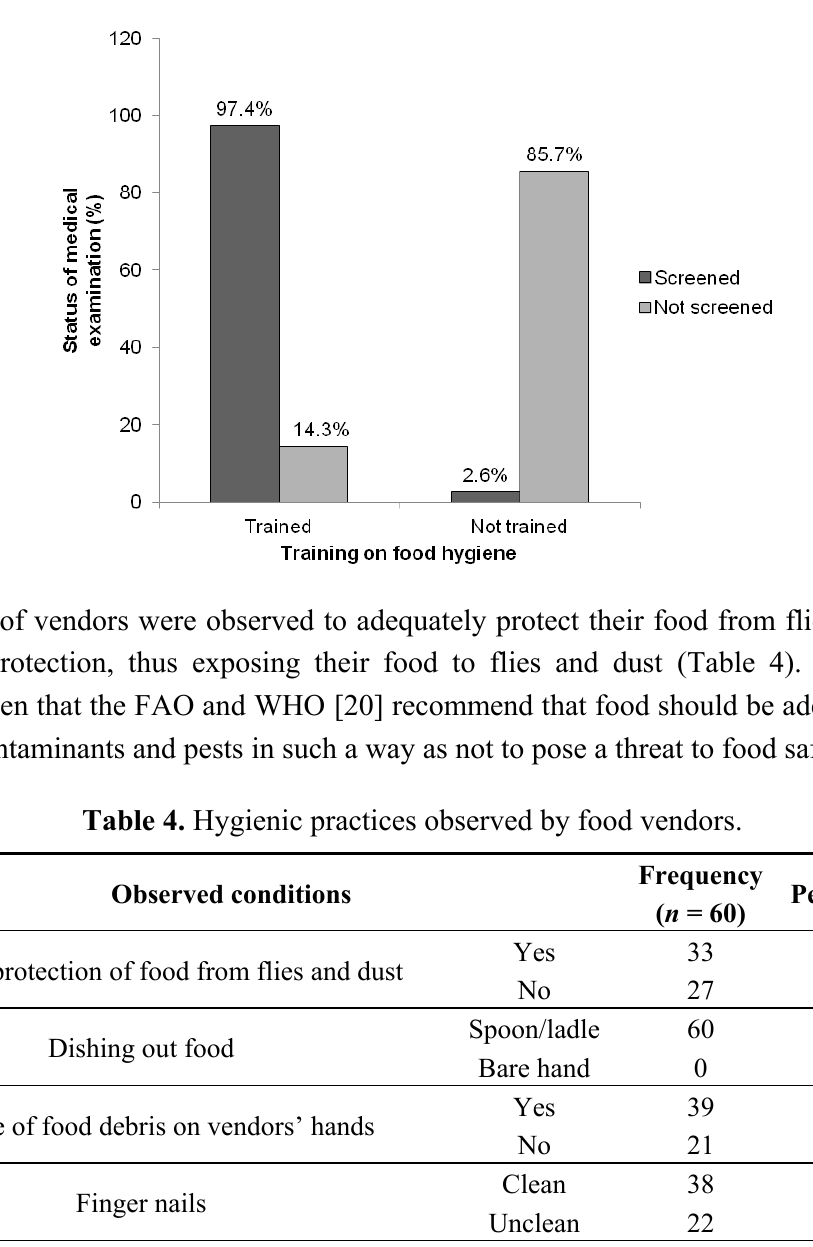
Figure 2. Comparative analysis between training on food hygiene and status of medical examination.